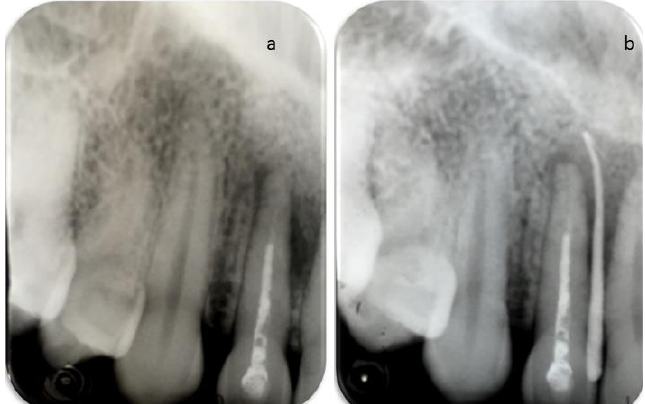
Figure 2. ( a ) Periapical radiograph depicting the presence of a previous root canal treatment on tooth 1.2 and a periapical radiolucency. ( b ) Periapical radiograph performed with insertion of a gutta-percha cone within the stoma to trace the sinus tract.